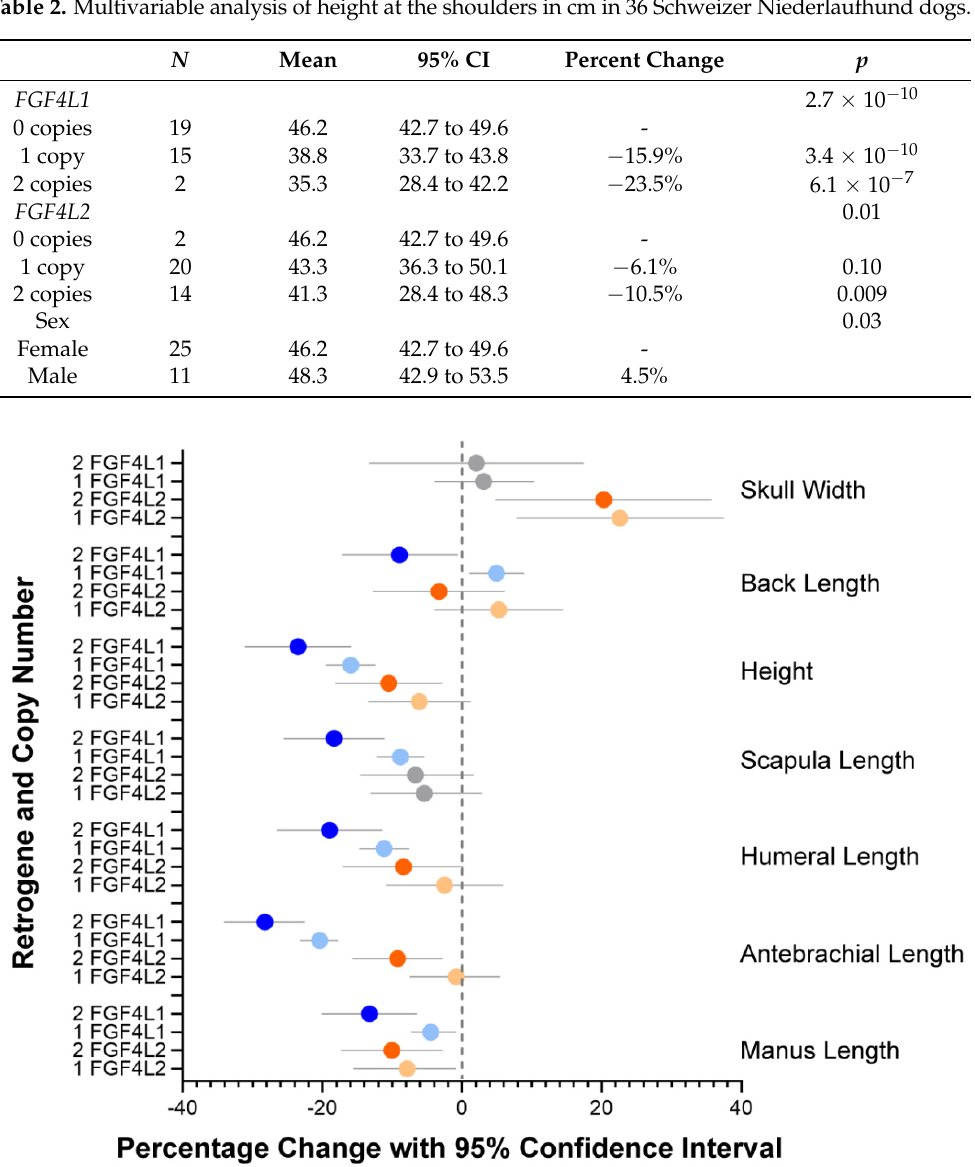
Figure 2. Measurements significantly affected by FGF4 retrogenes. The mean percentage change and 95% confidence interval in multivariable analysis of the measurements is shown. The dotted line represents the value of 0 copies of either retrogene. Blue color represents statistically significant effects of FGF4L1, and orange color represents statistically significant effects of FGF4L2. Shades of blue and orange represent copy number. Grey symbols were not significant. Complete multivariable results are in Supplemental Table S5.